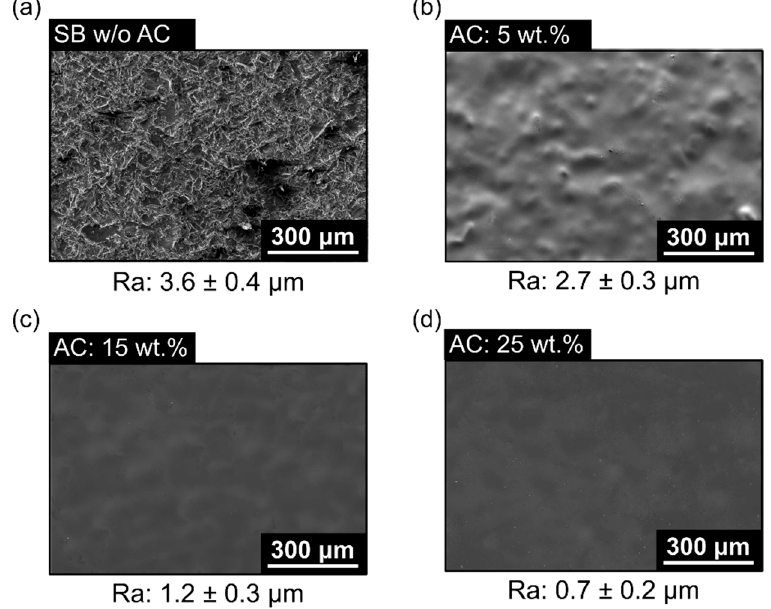
Figure 20. Surface roughness on the sandblasted aluminum surface: ( a ) without coating, ( b ) with 5 wt.% (condition eight), ( c ) with 15 wt.% (condition seven), and ( d ) with 25 wt.% (condition nine); (the following parameters PT: 280 °C, RT: 0.1 mm, DS: 60 mm/s, and NC: 2 were fixed for the conditions